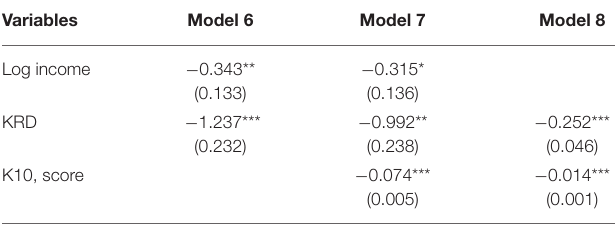
TABLE 5 | Sensitive analysis in rural older population (select results) a,b,c